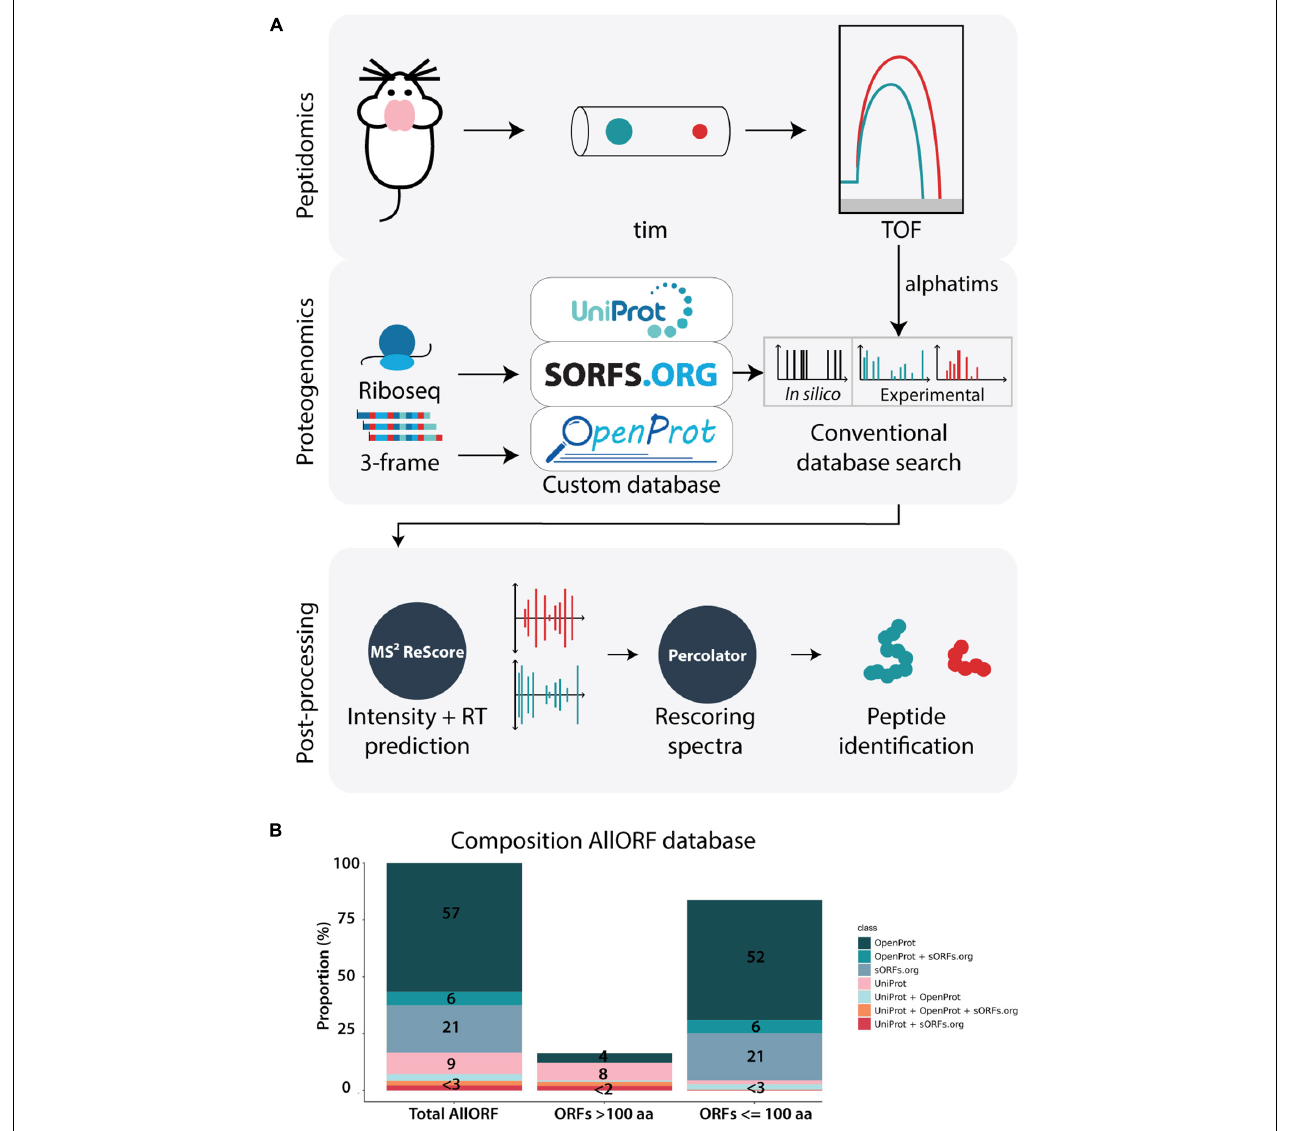
FIGURE 1 | Peptidomics workflow with timsTOF. (A) The applied workflow consists of three major steps: 1. Peptidomics, where brain tissue samples are analyzed on the sensitive timsTOF MS, 2. Proteogenomics, where translatomics information from ribosome profiling data and 3-frame RNA translations is complemented with the reference proteome to create a custom search database for subsequently conventional database searching with MSGF+, and 3. Post-processing with machine-learning based tools. MS 2 ReScore adds spectral intensity and retention time predictions to the feature matrix later fetched into the post-processing tool Percolator, improving the scoring of target PSMs, leading to the list of peptide identifications. (B) The composition of the proteogenomics database used in this study. Out of the total 546,530 sequences present, 309,463 originate from OpenProt only, 32,106 overlap between OpenProt and sORFs.org and 113,446 exist only in sORFs.org. Next to that, 51,995 are unique to the reference proteome, while 16,430 overlap between the reference proteome and OpenProt, 11,744 between the reference proteome and sORFs.org and 11,346 were present in the three